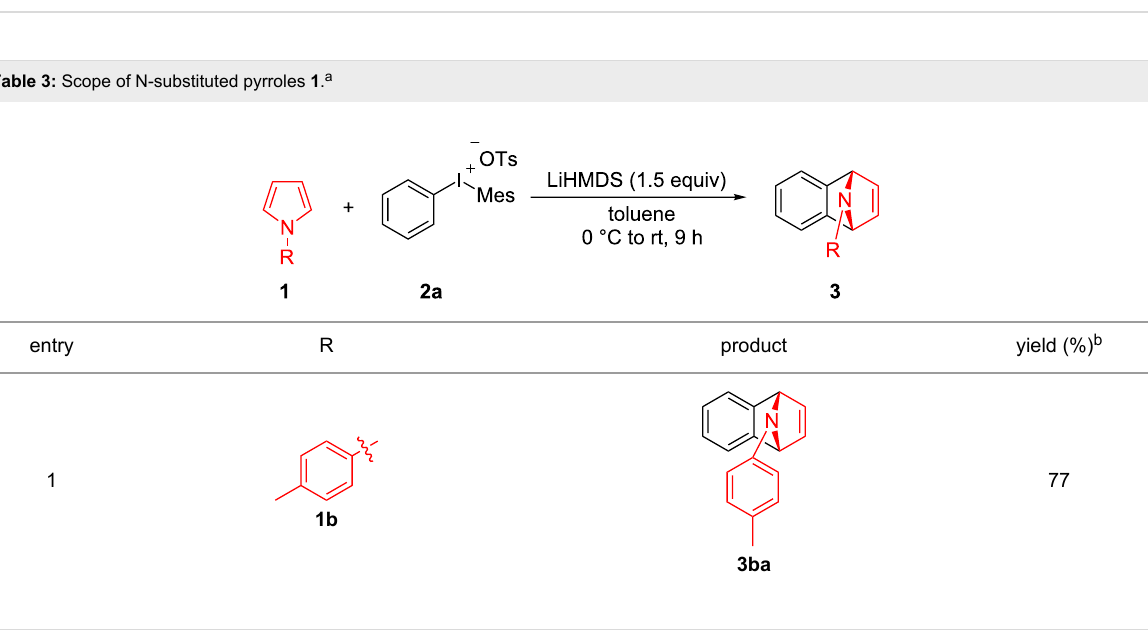
Table 3: Scope of N-substituted pyrroles 1 .